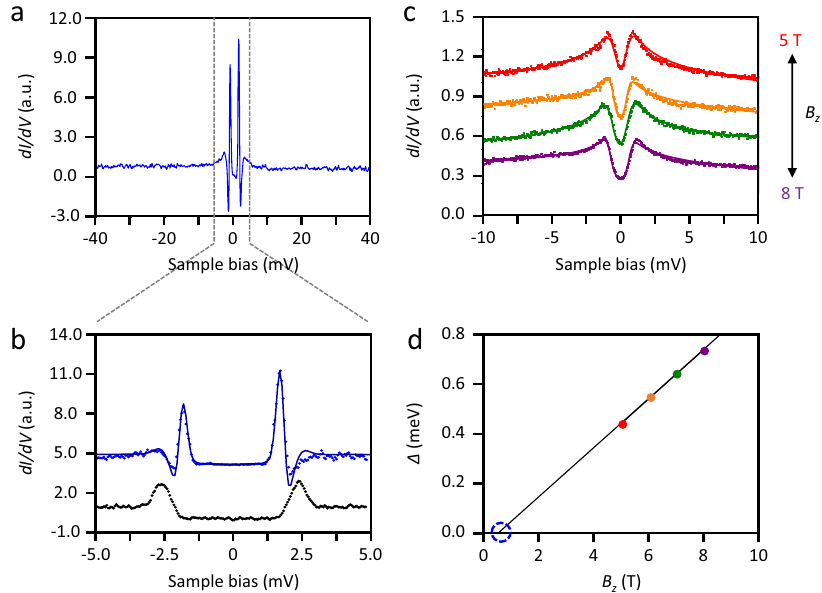
Fig. 2 Spectral features of a Cobalt phthalocyanine molecule with diagonal σ d mirror plane symmetry (CoPc d ). a , b Differential conductance (d I /d V ) spectra measured on the bare NbSe 2 sample (black dots) and the center of a CoPc d molecule (blue dots) by using a superconducting tip ( V = − 40 mV, I = 40 pA in a ; V = − 5 mV, I = 50 pA in b ). Here, V is the bias voltage, and I is the tunneling current. Full line in b is a least-square fi t to a scattering model in which the magnetic impurity is treated classically. c Differential conductance spectra measured on CoPc d at magnetic fi elds large enough to suppress superconductivity (dotted lines, V = − 10 mV, I = 100 pA) and least-square fi ts using a perturbative scattering model (full lines). Curves are vertically offset for clarity. d Extracted splitting Δ of the peaks in c and linear regression (full line). The dashed circle marks the crossing of the regression with the